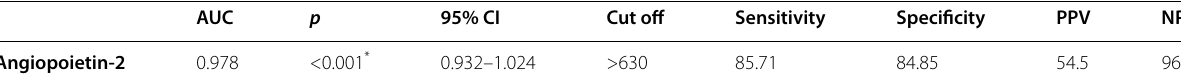
7) from F0–F3 ( n 33) = =